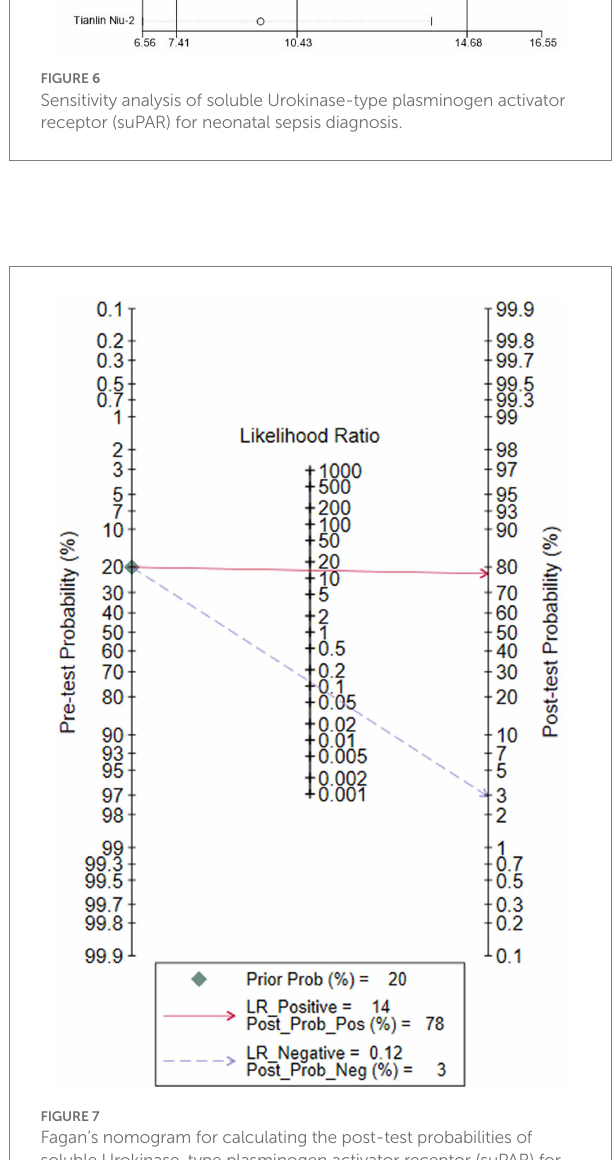
FIGURE 7 Fagan’s nomogram for calculating the post-test probabilities of soluble Urokinase-type plasminogen activator receptor (suPAR) for neonatal sepsis